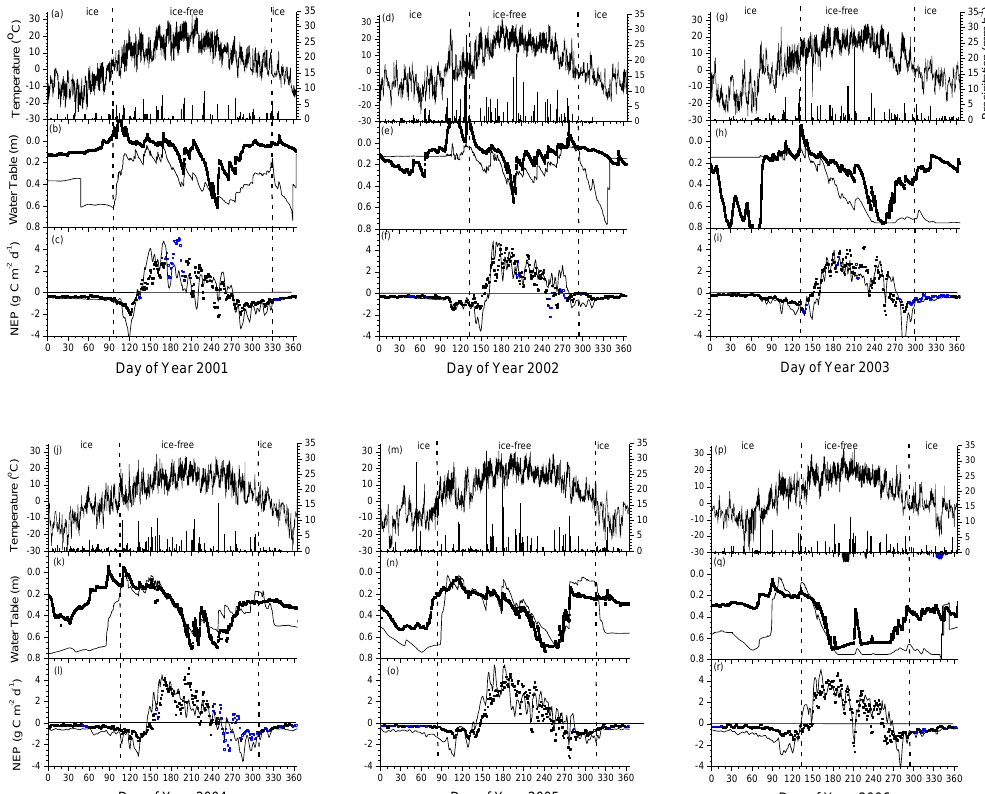
Fig. 2. Hourly air temperatures and precipitation, water table depth and net ecosystem productivity measured (symbols) and modelled (lines) from 2001 to 2006 at Lost Creek, WI. Open symbols represent daily totals calculated from more than 24 gap-filled 1/2-hourly